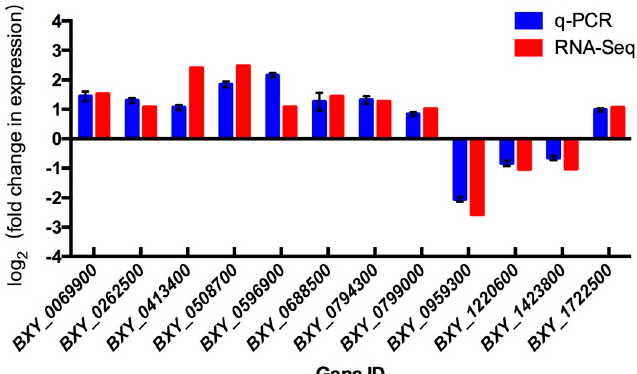
Figure 3. Quantitative real-time polymerase chain reaction (qRT-PCR) identification of differentially DEGs between low-temperature-treated and CK group nematodes. The relative gene expressions were normalized with the internal control gene Bx28S. The putative function of each gene is as follows: BXY_0069900, NH127; BXY_0262500, SERA; BXY_0413400, ST2B1; BXY_0508700, LIP1; BXY_0596900, ASK12; BXY_0688500, NHR54; BXY_0794300, NPY2R; BXY_0799000, DUS9; BXY_0959300, ADH3; BXY_1220600, SOCS4; BXY_1423800, AATC; BXY_1722500, CYSK2.